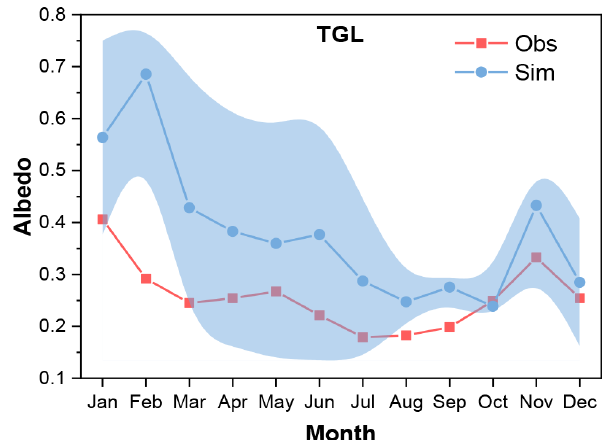
Figure 2. Monthly variations in ground albedo at the TGL site for the observations (Obs) and the ensemble simulation (Sim). The light blue shading represents the standard deviation of the ensemble sim-